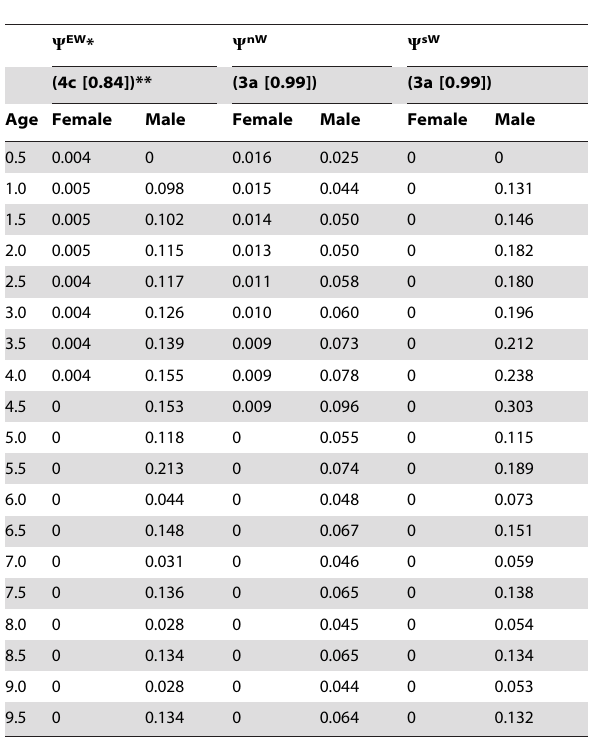
Table 5. Estimated seasonal age- and sex-specific occupancy probabilities for eastern DPS Steller sea lions being in their non-natal DPS during breeding (whole number) and non- breeding ( + 0.5) seasons; the estimates were derived from the best of 9 models for each set of estimates (see Table